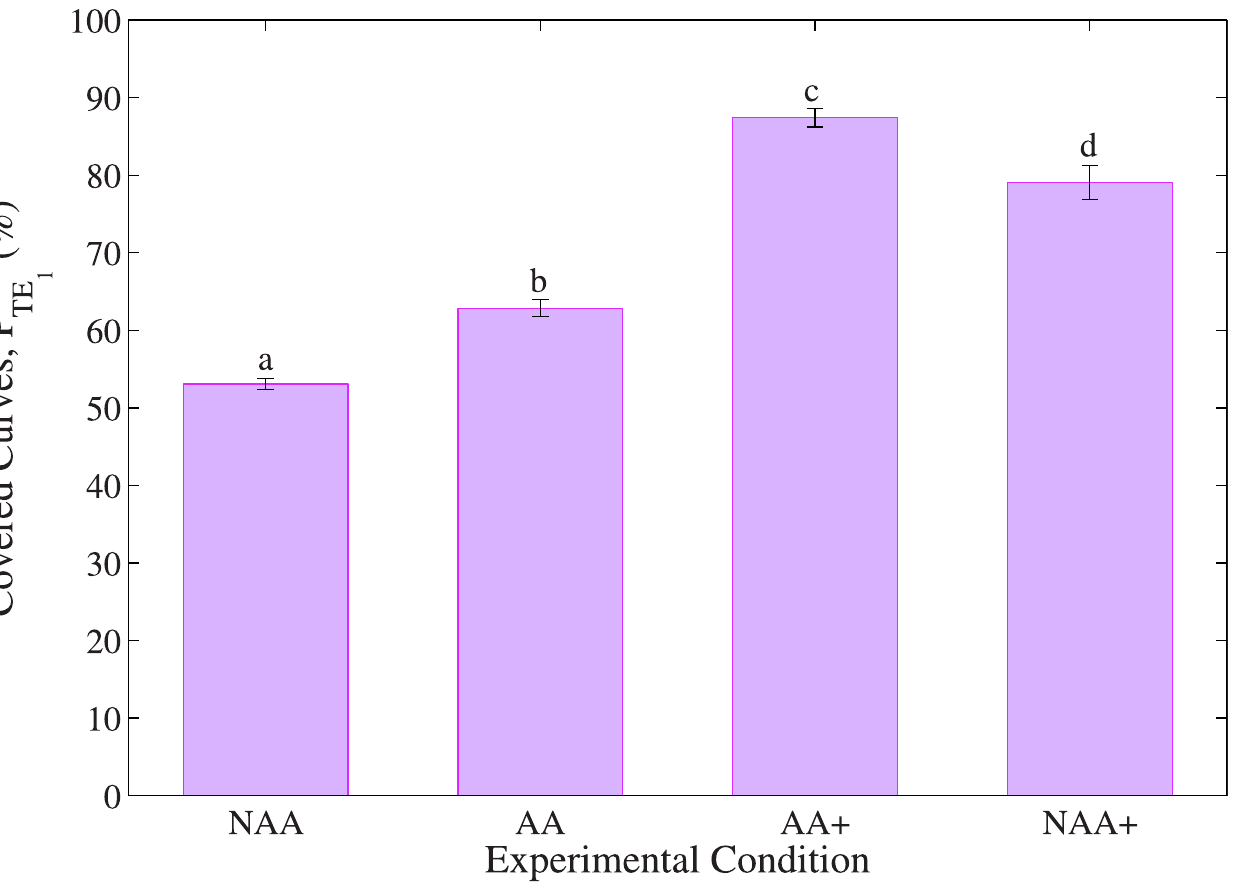
Fig 6. Median percentage of the curve path covered by the subjects for each experimental condition in TE. Error bars represent the standard error. Different letters on error bars indicate statistical significance in pairwise comparisons performed with Bonferroni post-hoc tests.